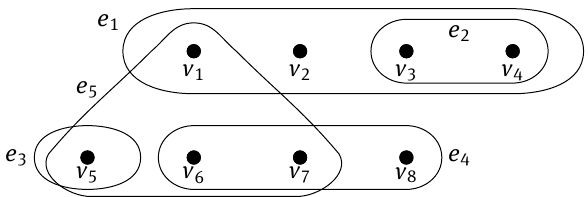
Figure 5: A hypergraph H 1 = ( V , E 1 )